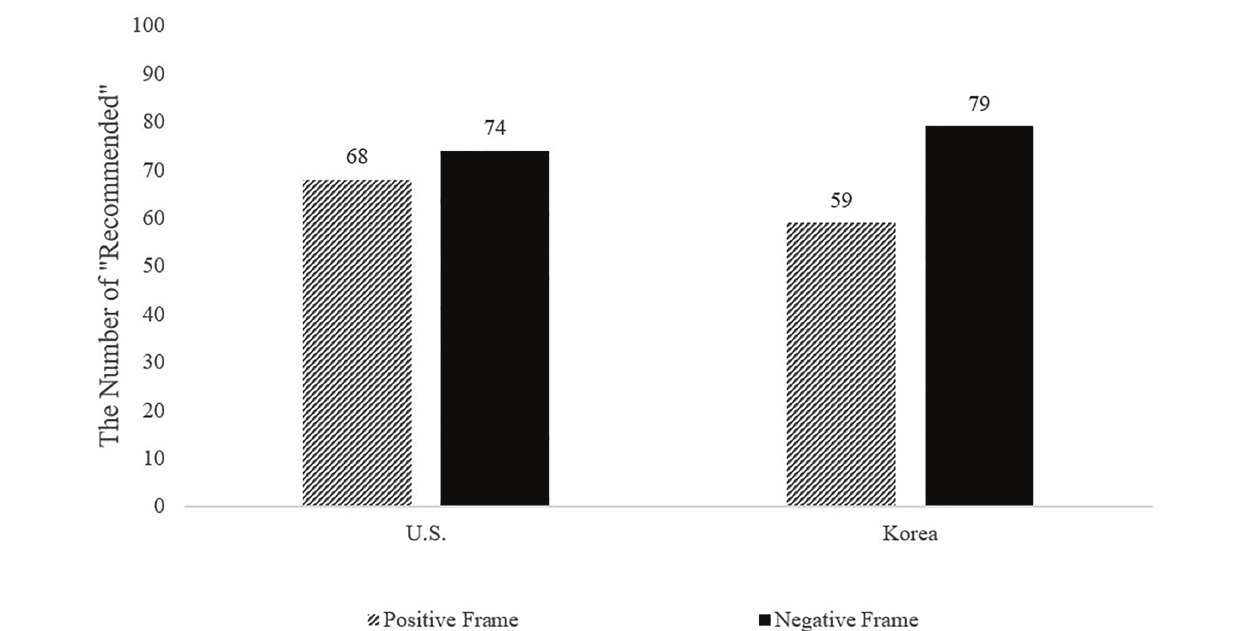
FIGURE 2 | Infection effect of frame × country on the number of “Recommended” reviews needed for purchase (Study